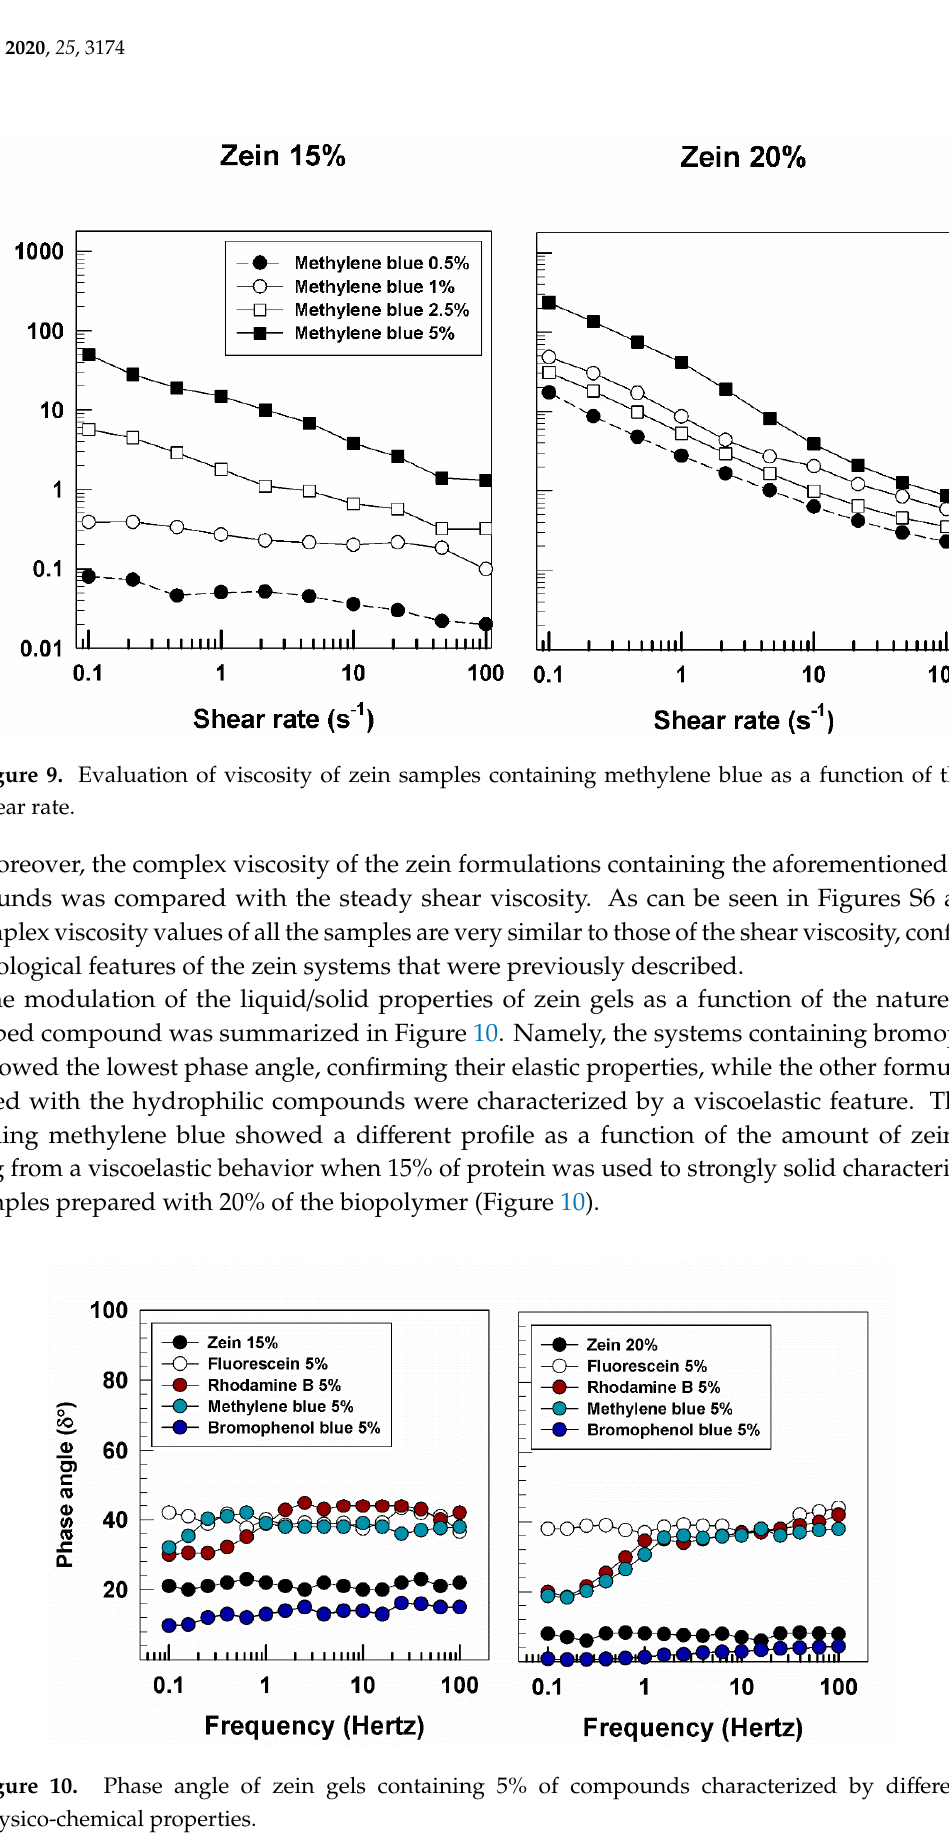
Figure 8. Evaluation of the elastic (G ′ ) and viscous (G ′′ ) moduli of zein gels prepared using 20% w/v of protein and containing methylene blue (0.5%, 1%, 2.5%, 5% w/w ) as a function of the frequency.